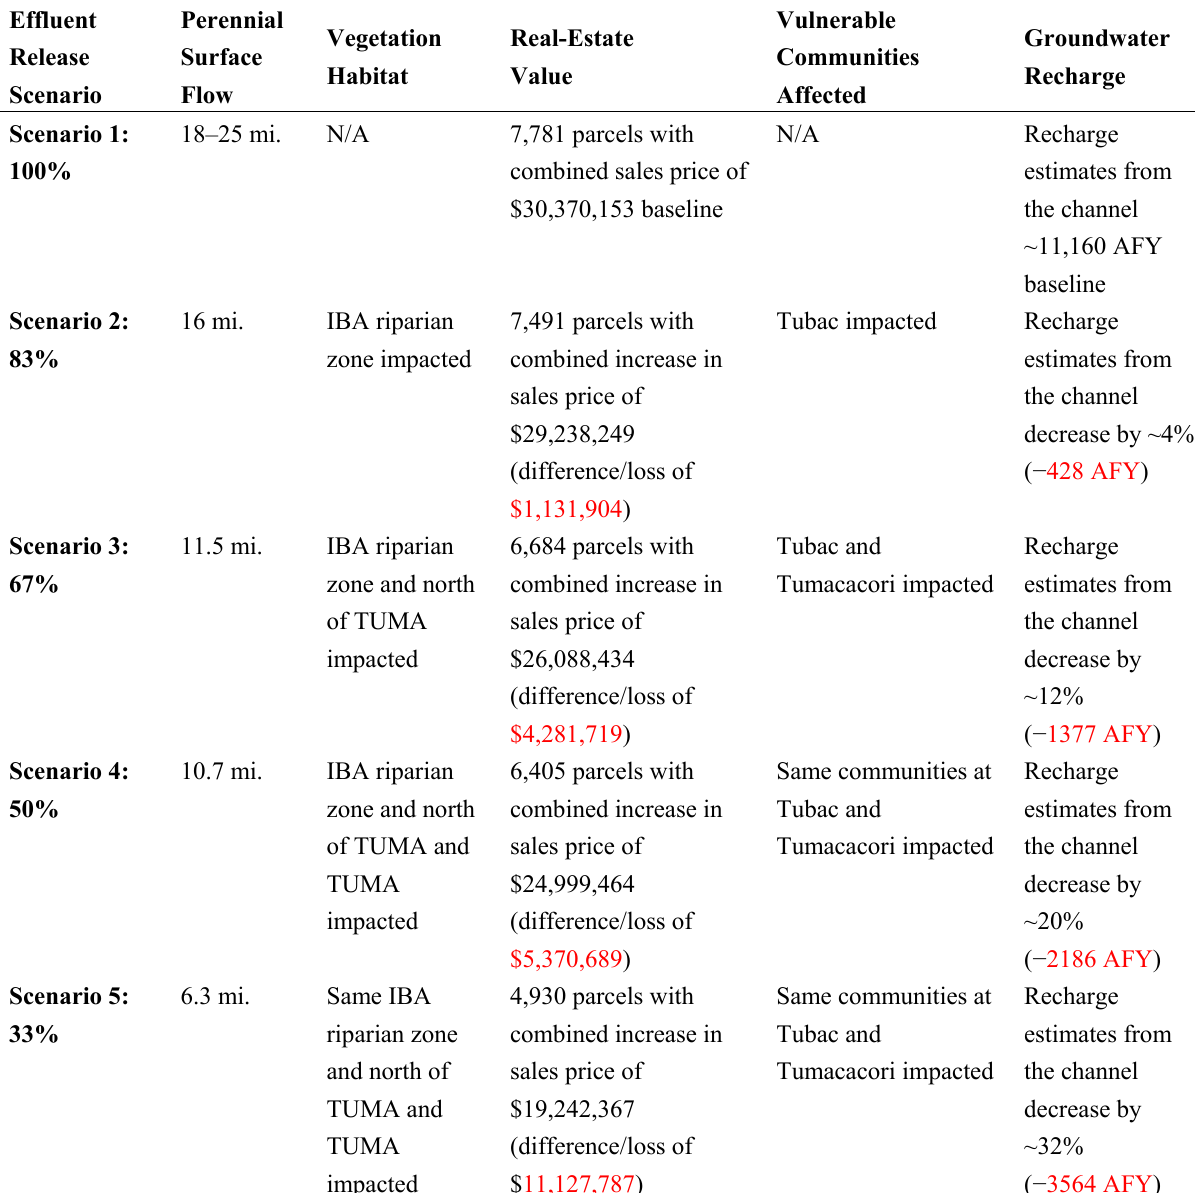
Table 1. Summary table of impacts to ecosystem services in the Santa Cruz River, Arizona, for varying effluent release scenarios. IBA, Important Bird Area; TUMA, Tumacácori National Historical